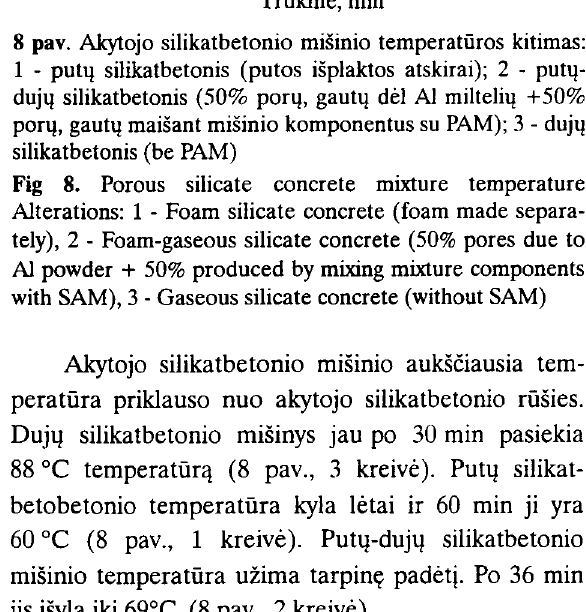
Fig 8. Porous silicate concrete mixture temperature